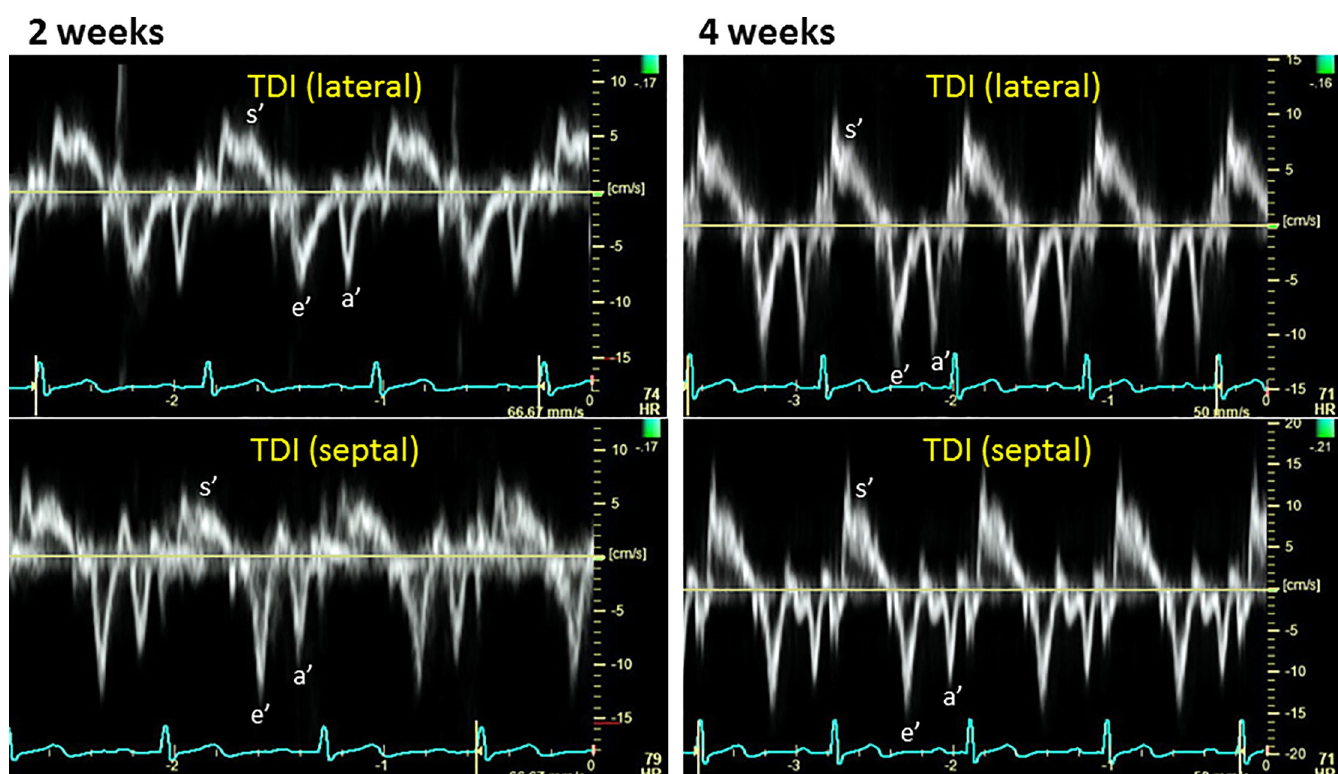
Fig 4. Tissue Doppler profiles for the lateral (top) and septal (bottom) corners of the mitral annulus, for the patient as in Fig 3.